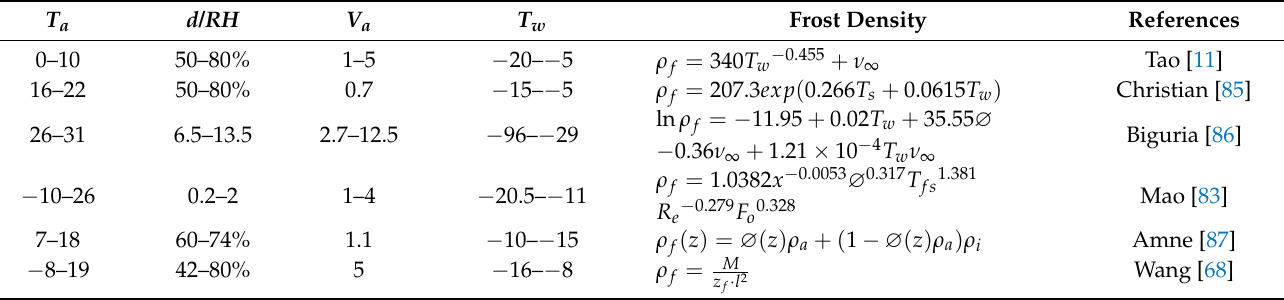
Table 3. The density variation of frost layer.